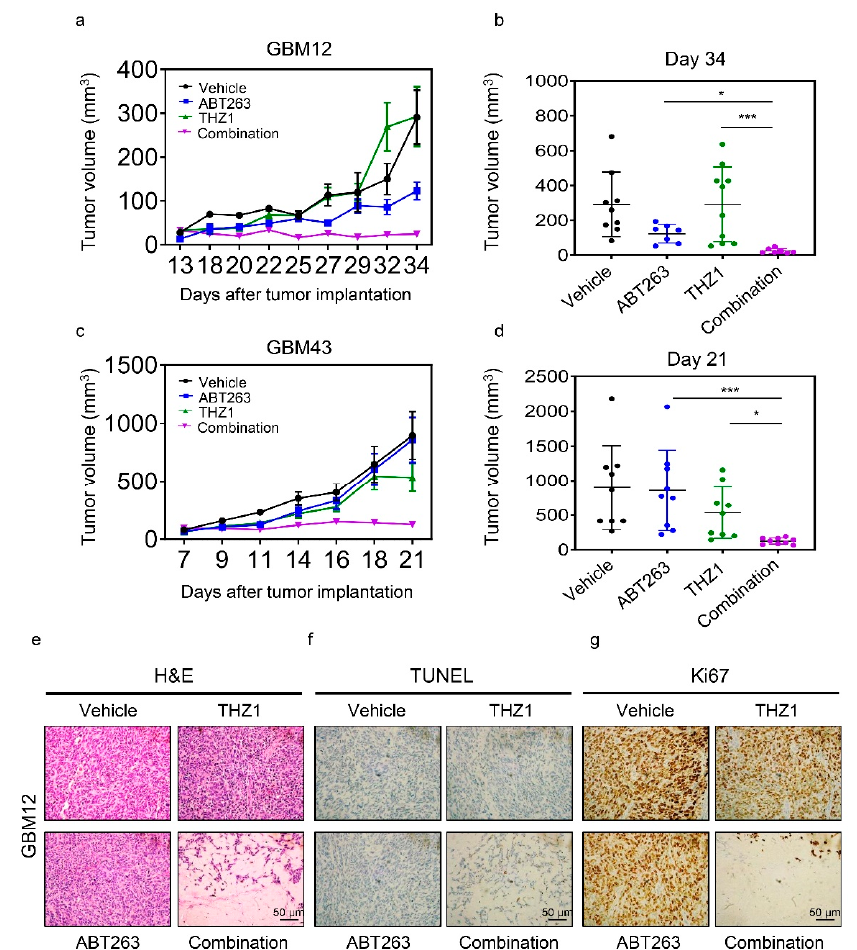
Figure 6. The combination treatment of ABT263 and THZ1 elicits anti ‐ glioma activity in patient ‐ derived xenograft model of human GBM. ( a ) GBM12 cells were implanted into the subcutis of immunocompromised Nu/Nu mice. Four randomly treatment groups—vehicle, ABT263 (75 mg/kg), THZ1 (10 mg/kg), and a combination of both—were assigned once the tumors were established. Mice were treated three times per week. Shown are the tumor volumes over time; ( b ) The graph shows tumor volume on the last day of the experiment in ( a ) ( n = 7–10); ( c ) GBM43 cells were implanted into the subcutis of immunocompromised Nu/Nu mice. Four randomly treatment groups, vehicle, ABT263 (75 mg/kg), THZ1 (10 mg/kg), and the combination treatment of both, were assigned once the tumors were established. Mice were treated three times per week. Shown are the tumor volumes over time; ( d ) The graph shows tumor volume on the last day of the experiment in ( c ) ( n = 9); ( e ‐ g ) Tumors from the experiment in ( a ) were fixed and stained with H&E, TUNEL or Ki67. Shown are means and SD. ANOVA was used for statistical analysis. * p < 0.05, *** p < 0.001. Scale bar: 50 μ m.